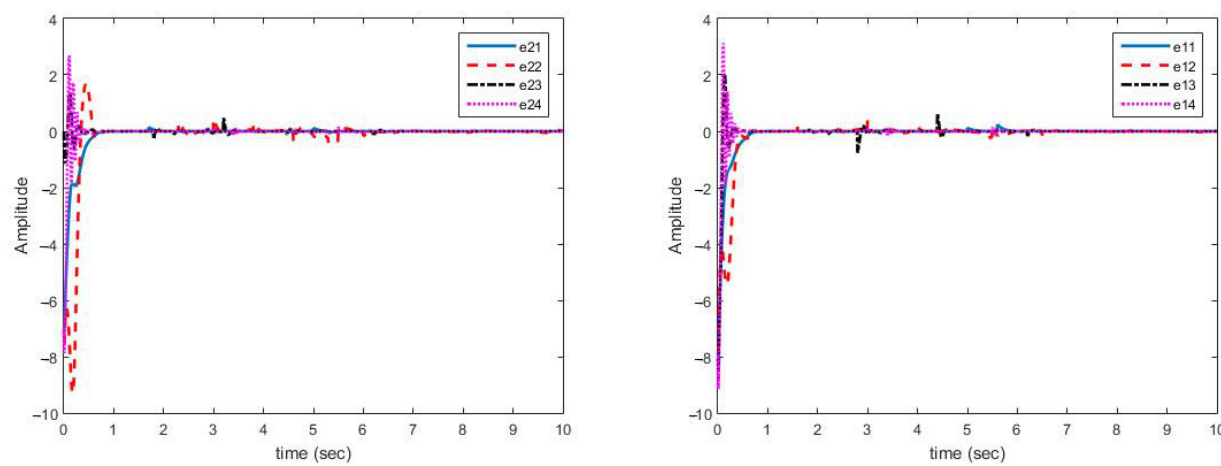
Figure 4. Multi-state synchronization error curves (case A).